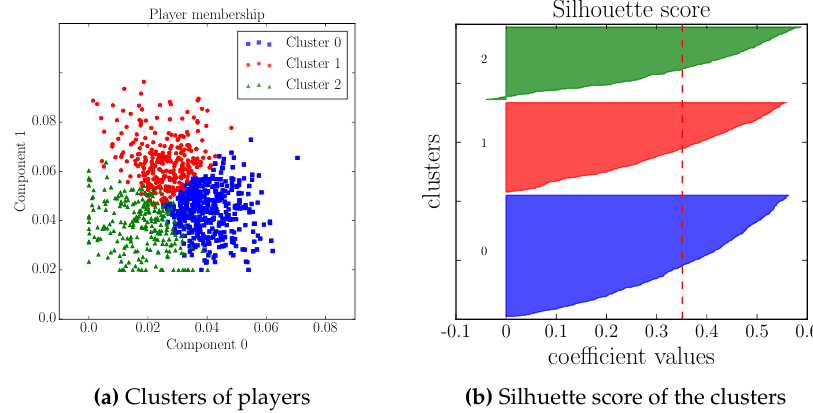
Figure 3. K-means results: (a) 2-dimensional projection of the three clusters identified by the k-means. Each dot represents a player in its corresponding cluster, and the dot’s coordinates are given by the first two columns of the matrix A . (b) Silhouette scores of the users belonging to the three clusters. The red line identifies the final Silhouette score of 0.35, and the width of the Silhouette profiles indicates the size of the corresponding